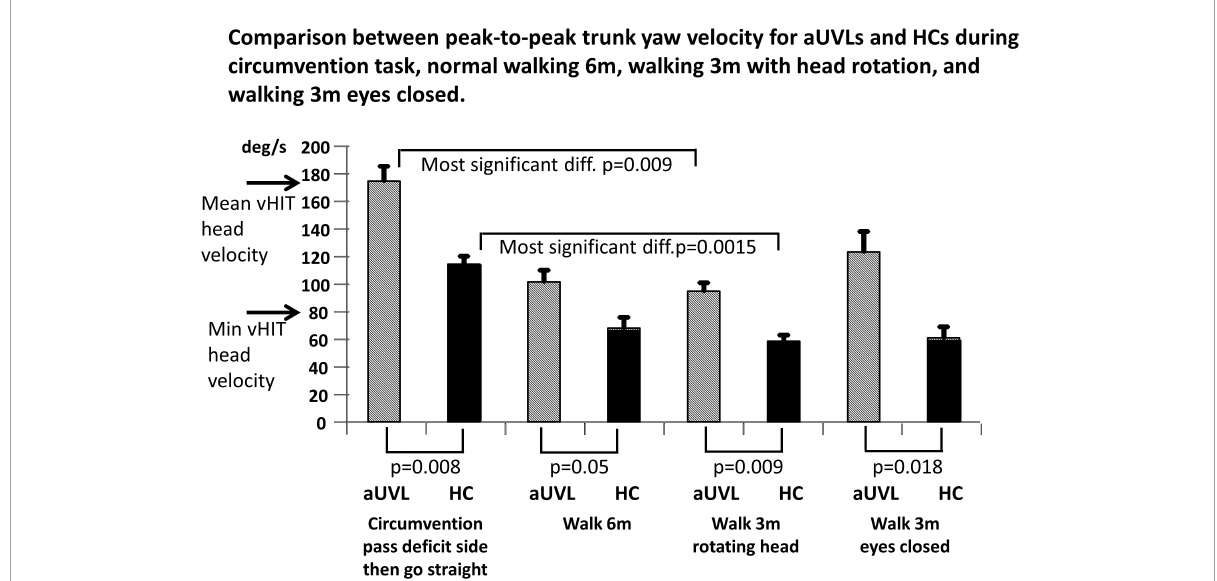
FIGURE8 Mean peak-to-peak yaw angular velocities for the circumvention task showing the most significant differences (after Bonferroni correction) between subjects with aUVL and HCs, compared to peak-to-peak differences, for the clinic gait tasks of walking 6 m, walking 3 m with simultaneous head rotations, and walking 3 m with eyes closed. Horizontal arrows on the trunk yaw angular velocity ordinate indicate the minimum acceptable and mean yaw head velocity used for video head impulse tests of the yaw vestibular ocular reflex (data from Cleworth et al.,